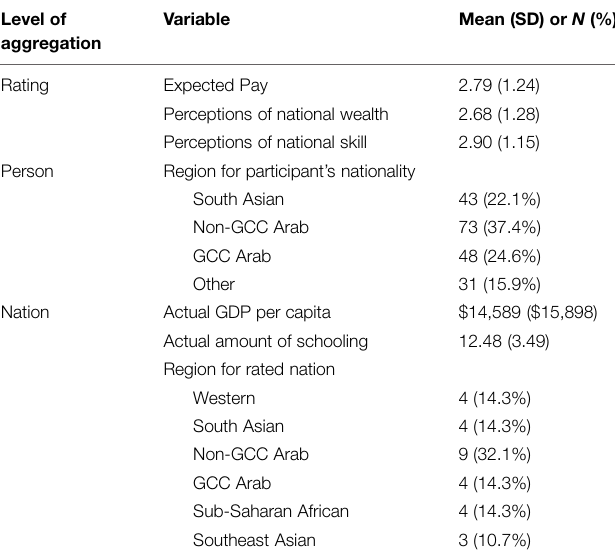
TABLE 1 | Descriptive statistics for study